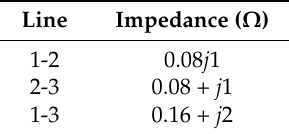
Table 13. Line data for Case IV.